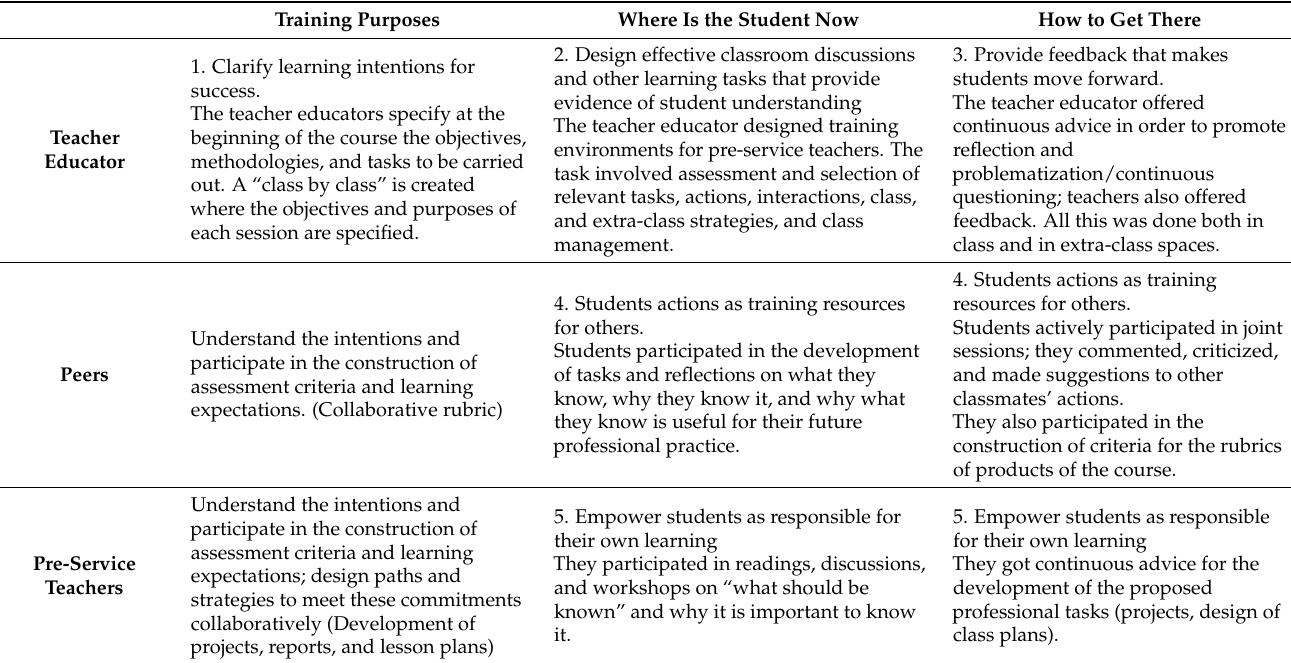
Table 1. Aspects of formative assessment adapted to this